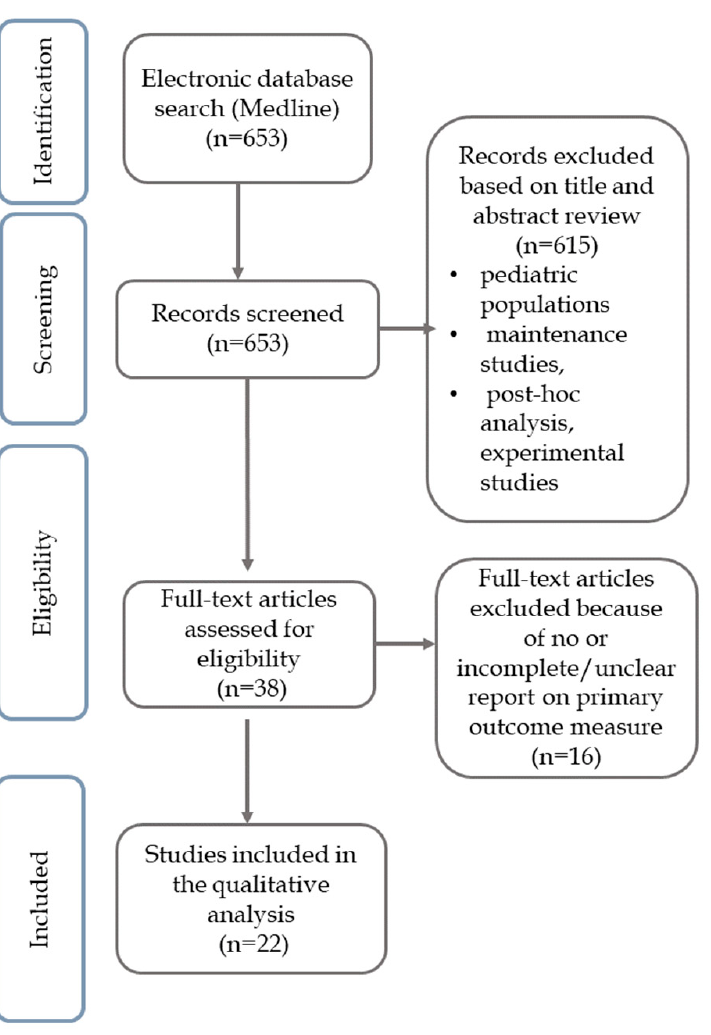
Figure 1. Study selection flowchart.